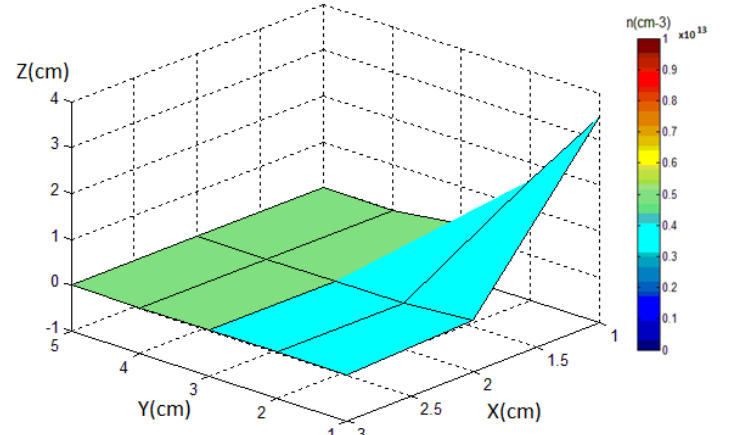
Figure 7: The spatial profile of electron number density of carbon laser induced plasma at z=5cm.